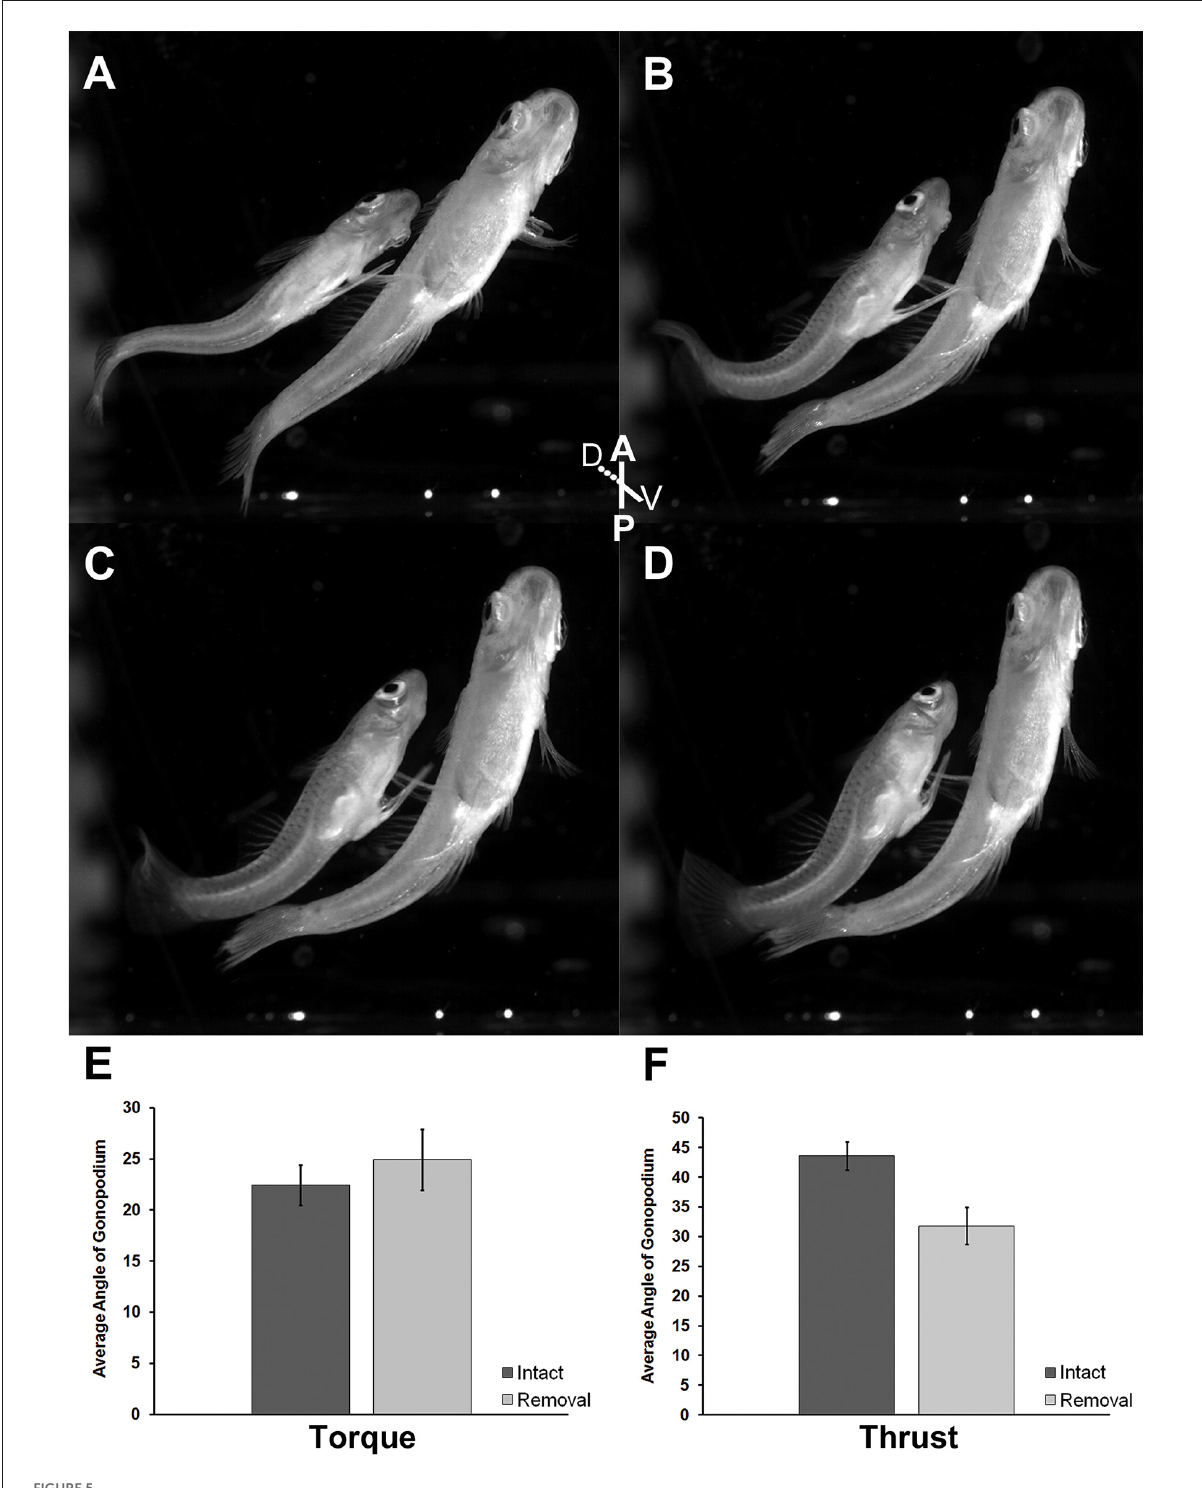
FIGURE5 Ventral view of adult male mosquitofish performing Torque (A,B) and Thrust (C,D) maneuvers of gonopodial circumduction after removal of superficial neuromasts from the base of the anal fin. Average angle of gonopodium in the torque (E) and thrust (F) maneuvers of gonopodial circumduction after removal of superficial neuromasts. Torque ( t = -0.72; df = 9; P = 0.49), control ( intact ; mean = 22.45, SD = 5.19; dark gray column), experimental ( removal ; mean = 24.91, SD = 5.91; light gray column). Thrust ( t = 3.01; df = 9; P = 0.01), control ( intact ; mean = 43.59, SD = 6.22; dark gray column), experimental ( removal ; mean = 31.84, SD = 6.26; light gray column). Black vertical bars = standard